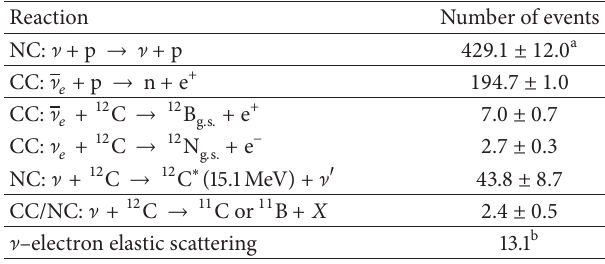
Table 5: Supernova neutrino interaction channels in LAB-PPO. The event rates, per 780 tonnes of material, assume the incoming neutrino time-integrated flux described in the text. No flavor changing mechanisms are considered. The uncertainties on the event rates only include the cross section uncertainties [16].